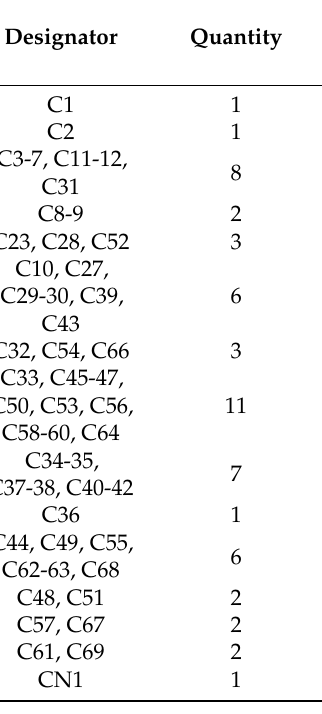
Table 2. Acoustic and multipurpose device bill of